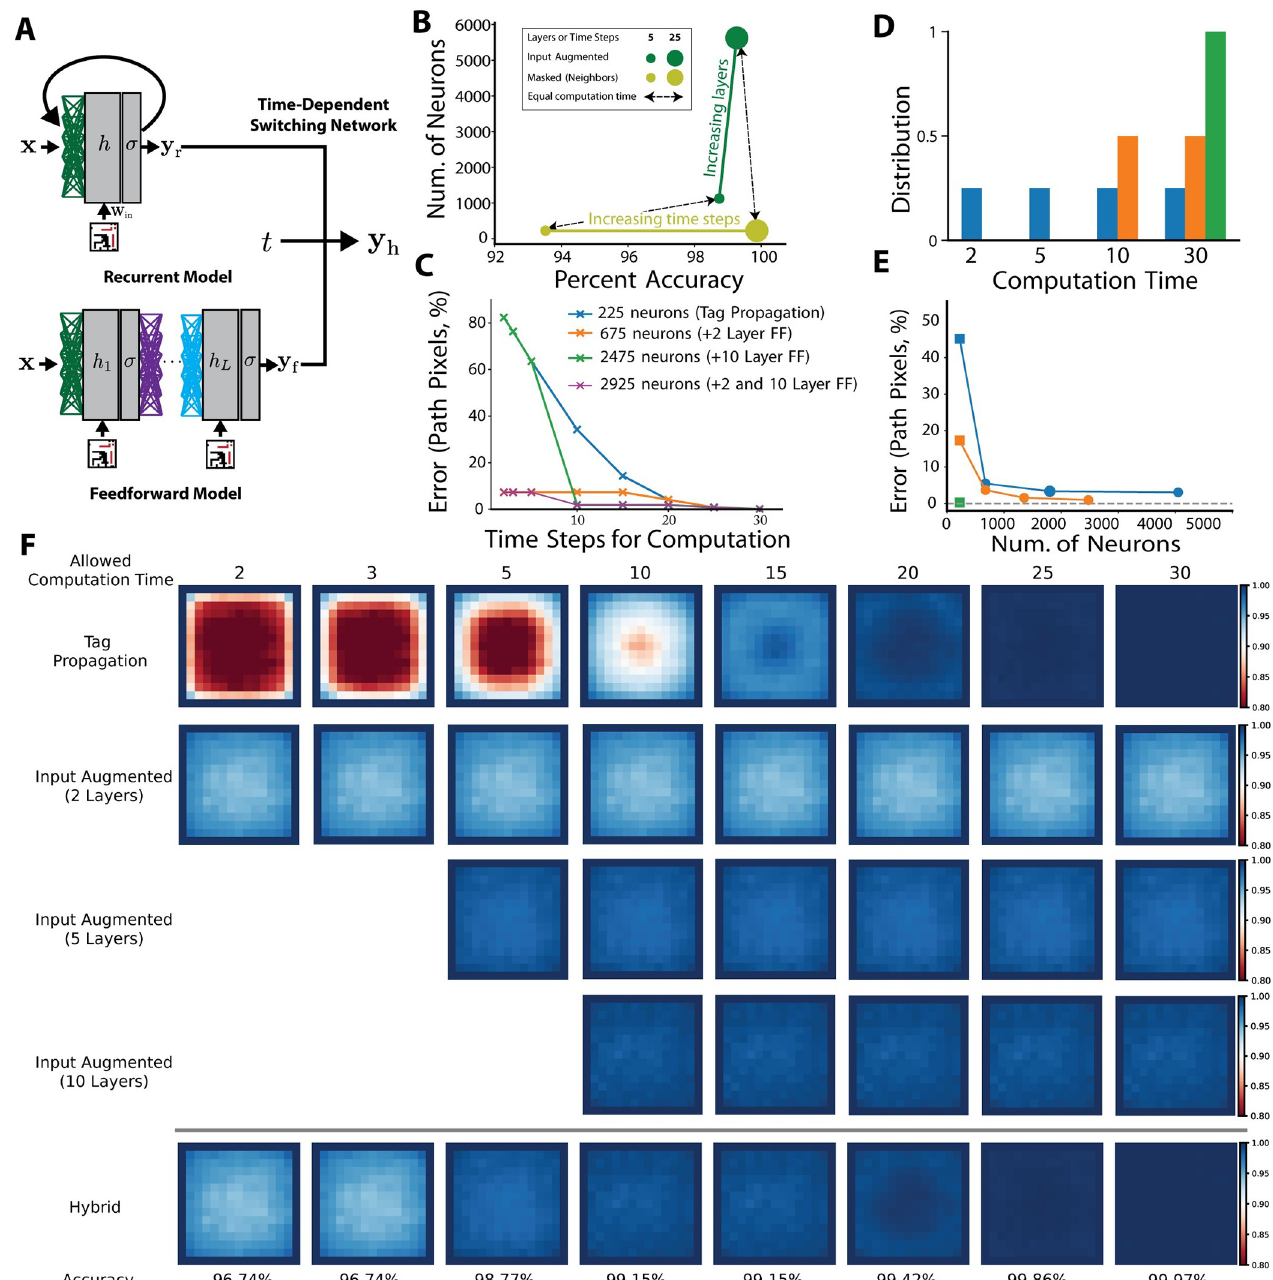
Fig 4. Performance comparison of uniform and hybrid networks on the edge-connected pixel task. (A) Schematic of a general hybrid network combining a recurrent and feedforward model. For any time-step t , the switching network combines the current output of the recurrent network y r and the output of the feedforward network y to form the hybrid output y . Note that the feedforward output can only be used by the switching network when t is greater than or f h equal to the number of layers in the model. (B) Performance of the best solution after hyperoptimization type plotted against the number of neurons to motivate why combining these two architectures into a hybrid networks can provide better performance across a range of computational times. The feedforward architecture (input augmented) provides a superior neuron/performance tradeoff at low computational time while the recurrent architecture (masked neighbors) provides a superior neuron/performance tradeoff at high computational time. Colors correspond to different network architectures. Small circles correspond to recurrent networks run for five timesteps and feedforward networks with five layers. Large circles correspond to architectures that use 25 timesteps or layers. Solid colored lines connect models of the same architecture with different layers or time steps. Dotted lines with arrows highlight the masked and feedforward architectures with equivalent layers or timesteps for ease of comparison. (C) Performance of hybrid architecture designed to be able to switch on-the-fly based on how many time steps are available to output a labelling. Here we consider the simplest switching network which can choose to either to output y or y at a given time step. The model combines the tag propagation solution and trained input augmented networks; the budget for each curve is r h